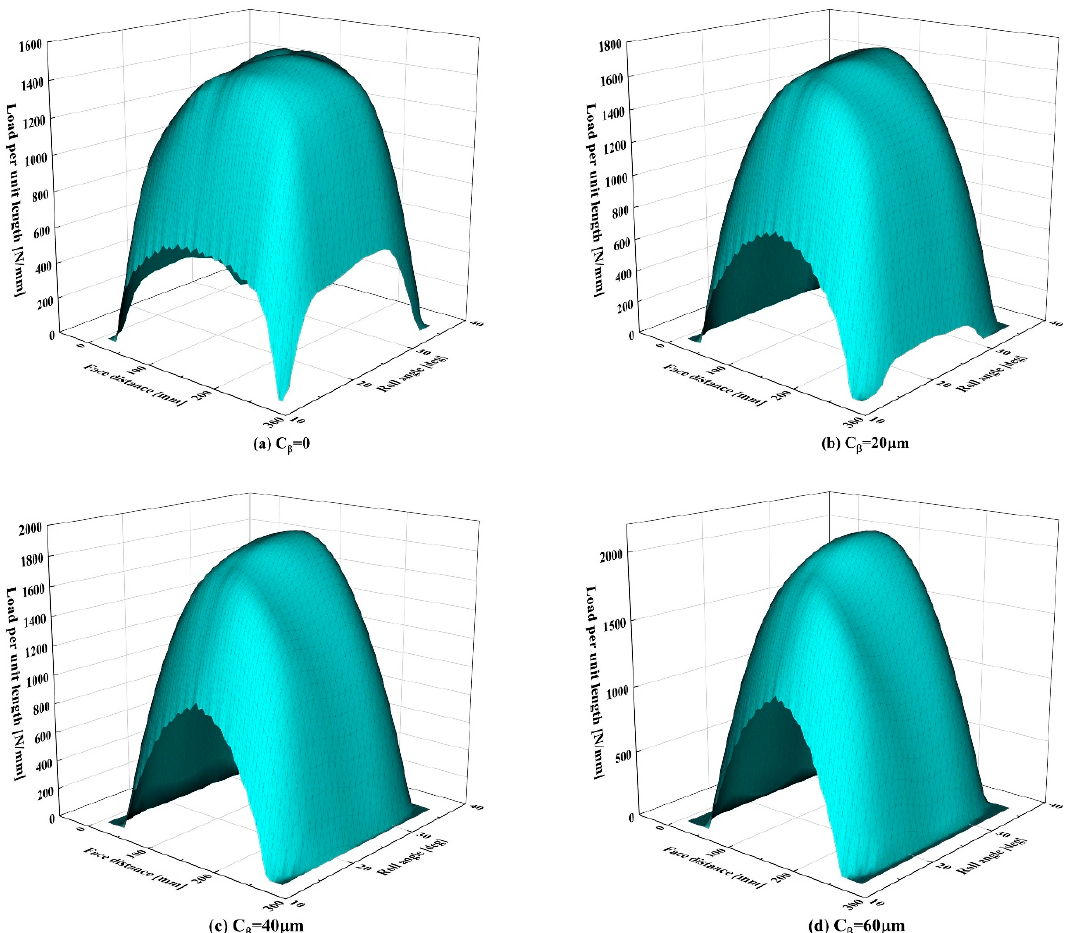
Figure 17. Gear crowning modification.